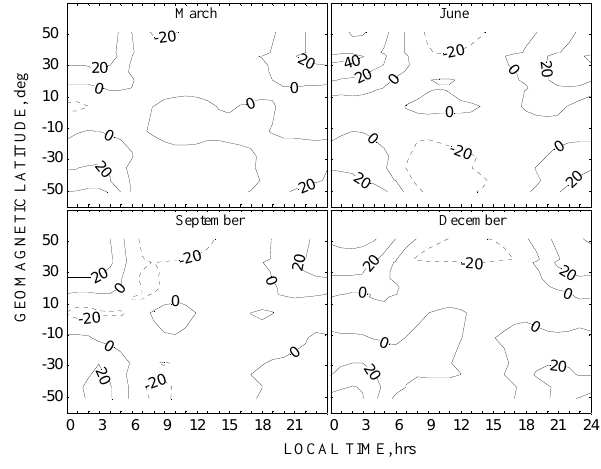
Fig. 1. The averaged diurnal and latitudinal variation of the vertical equivalent winds (VEWs) in each season for solar minimum. Positive upward.